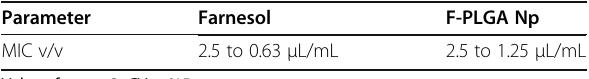
Table 1 MIC range values observed for farnesol and F-PLGA Nps against and Candida albicans Parameter Farnesol F-PLGA Np Values for n = 3; CV ≤